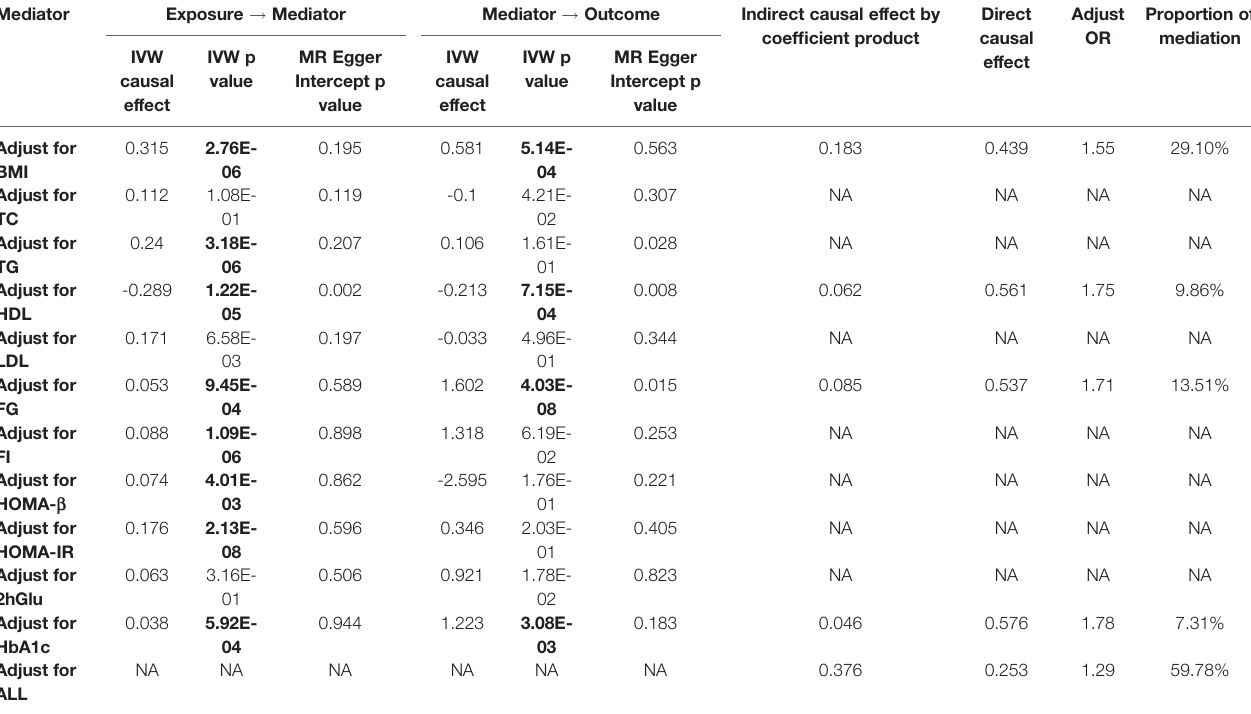
TABLE 4 | Two-step Mendelian randomization mediation analysis of the association between TV watching (exposure) and type 2 diabetes (outcome).